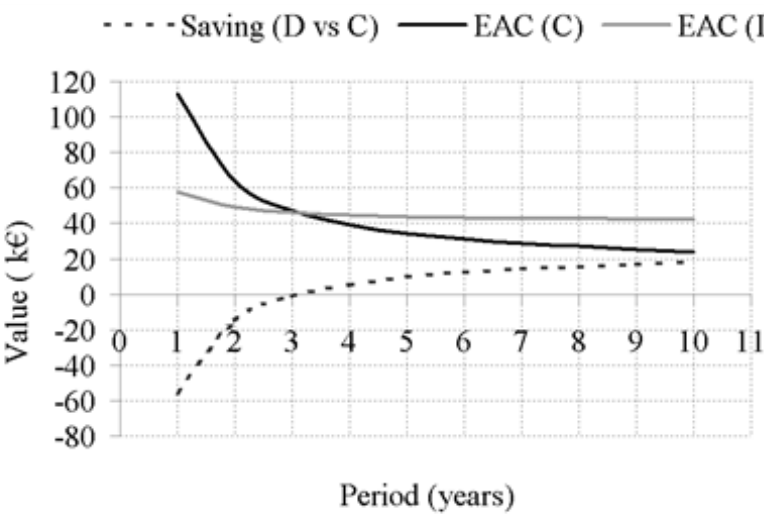
Figure 4. Variation of the Equivalent Annual Cost (EAC) for the different heating systems in relationship with the duration of the management period (C = wood chips heating system; D = Diesel heating system) and saving of C vs.